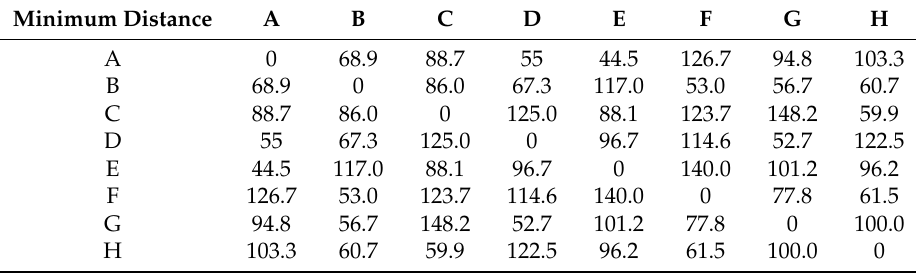
Table 12. Minimum distance between